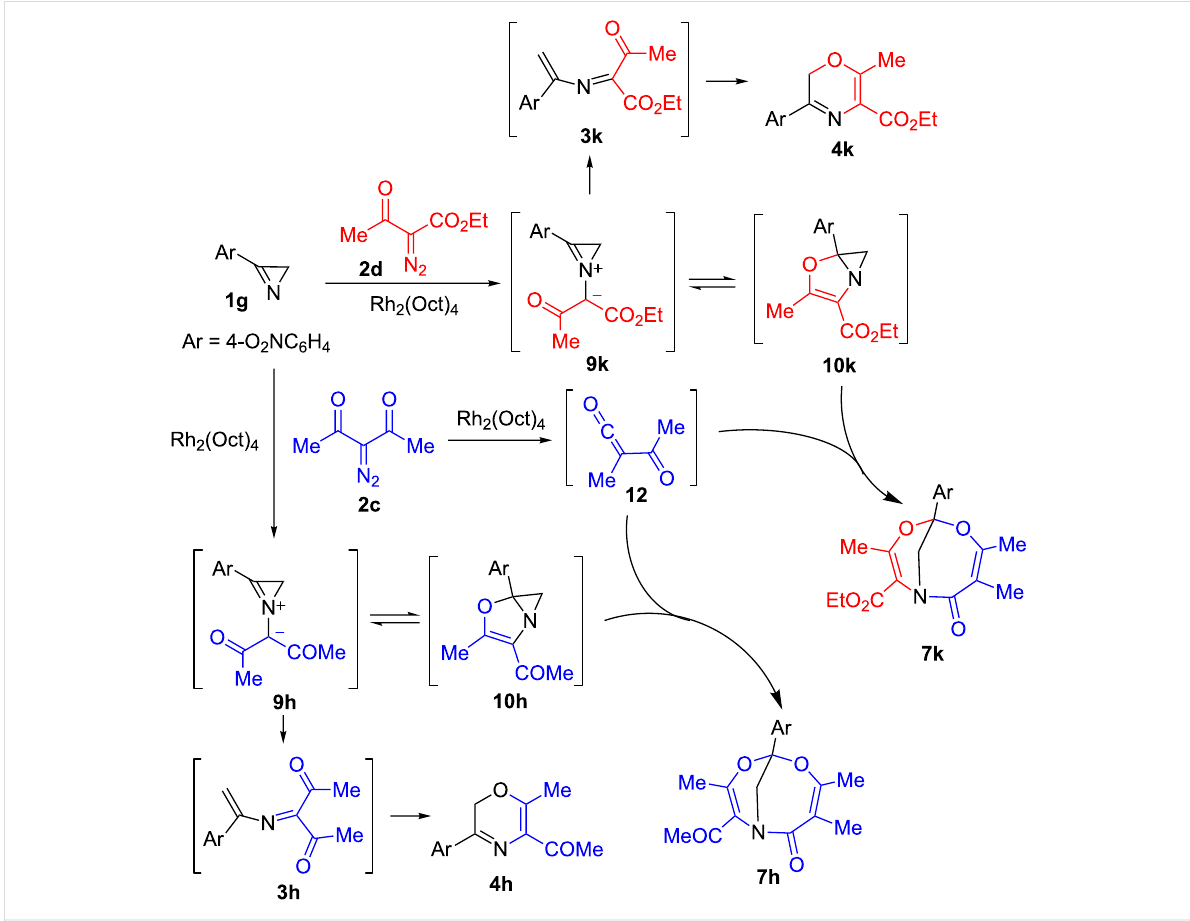
Supporting Information File 1, Scheme S1) formed from